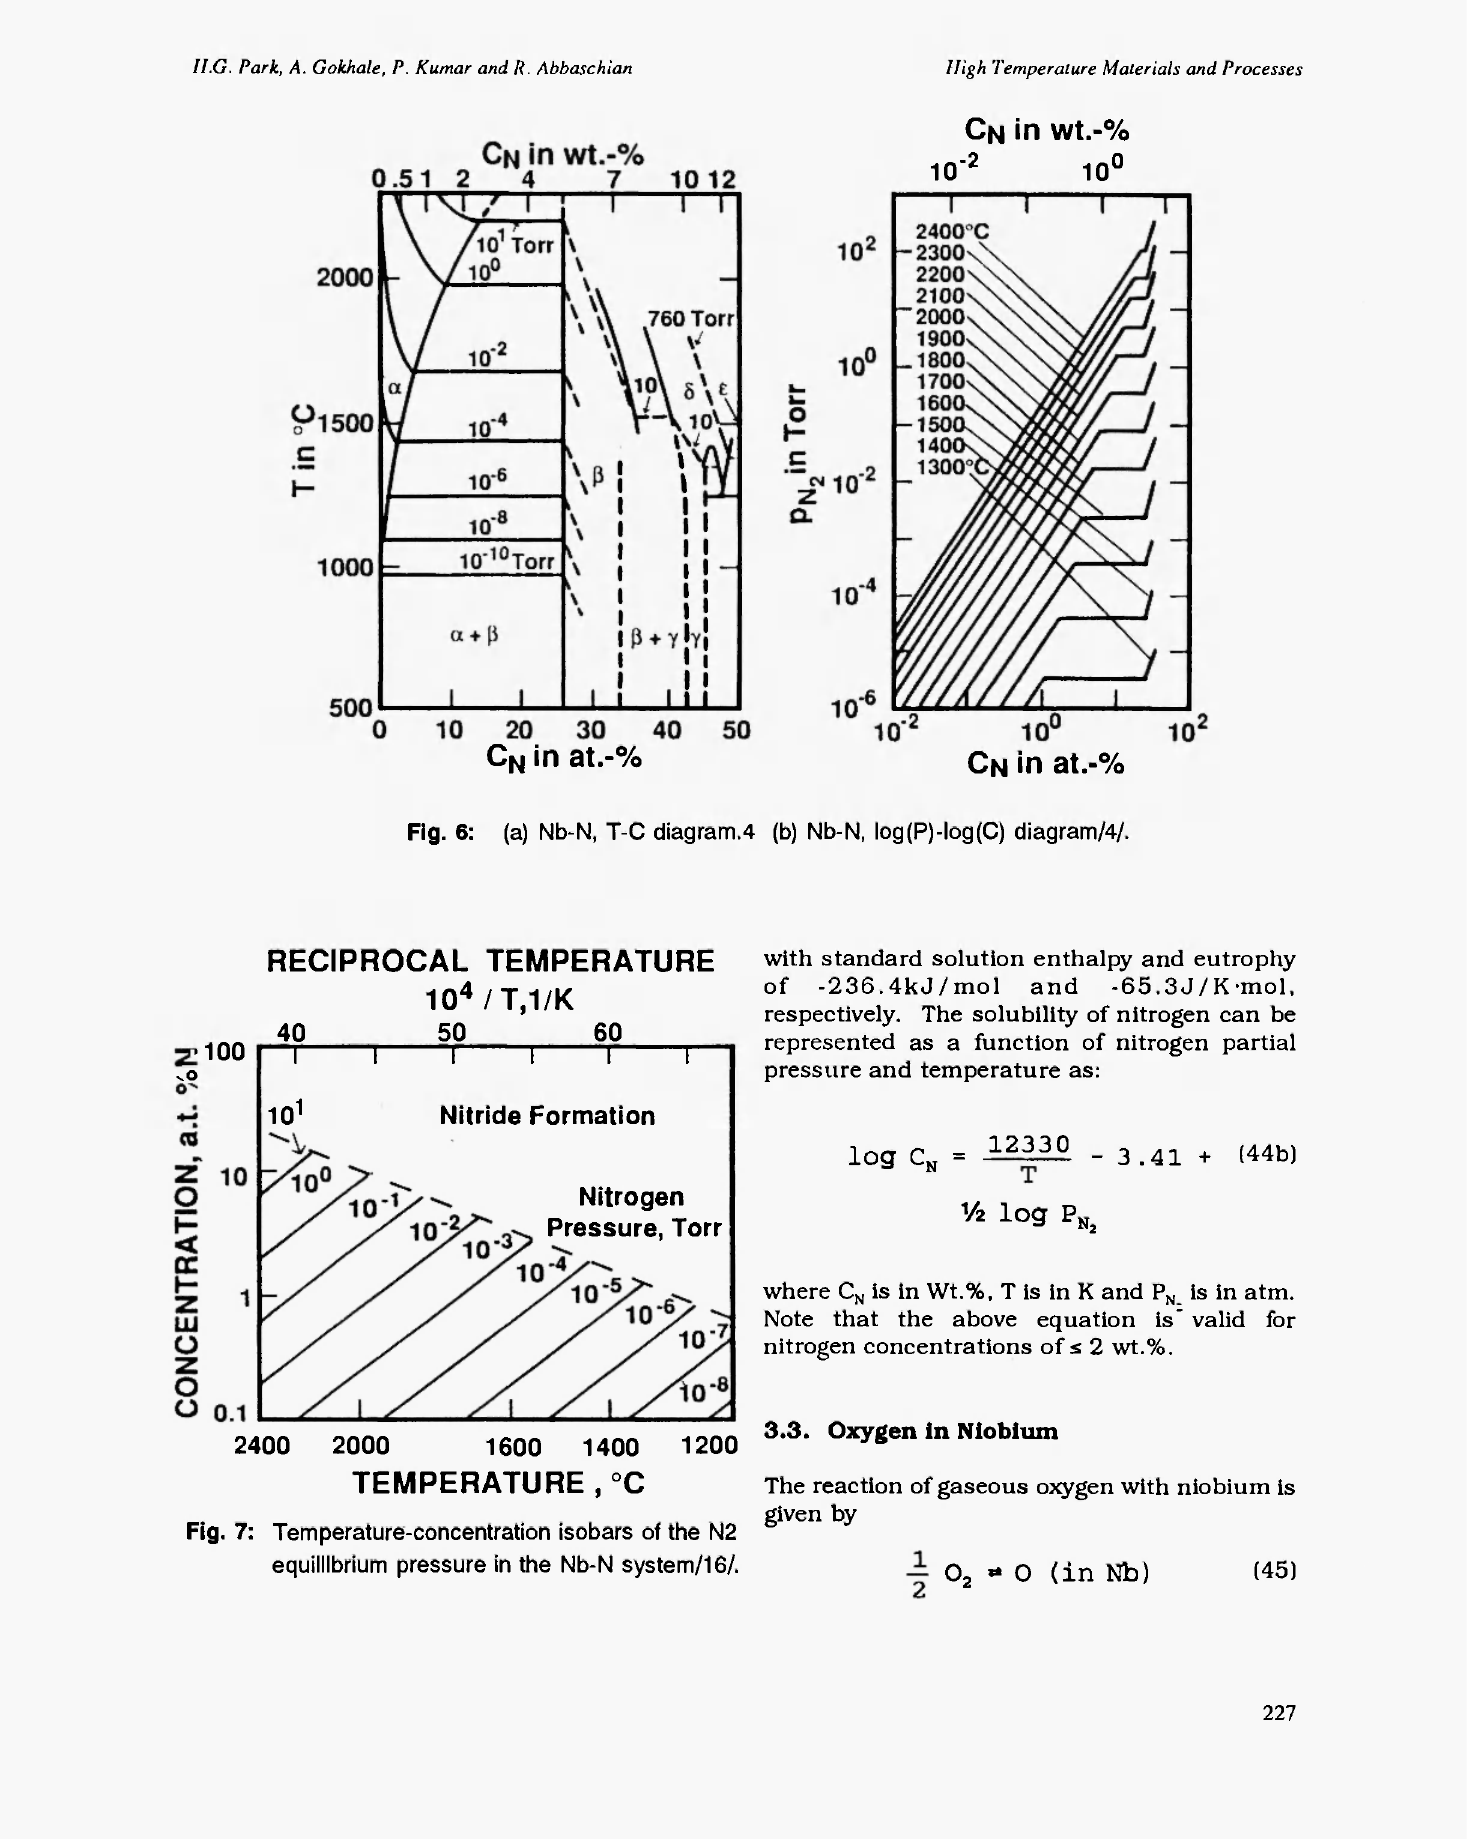
Fig. 7: Temperature-concentration isobars of the N2 equilibrium pressure in the Nb-N system/16/.